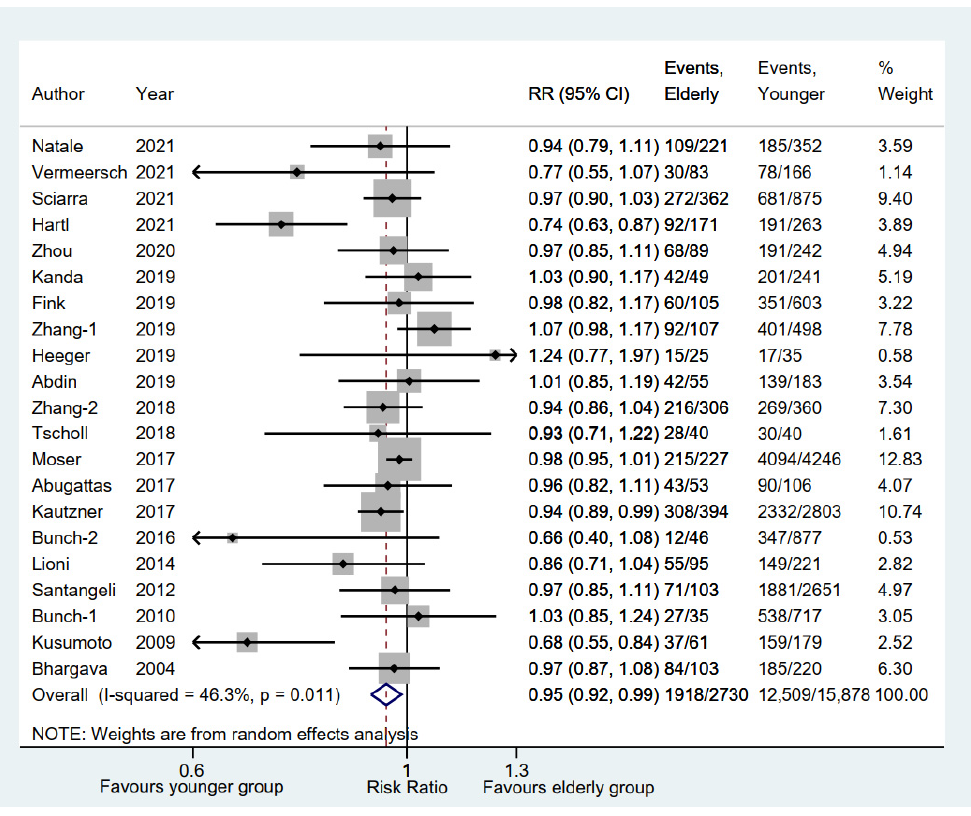
Figure 2. Forest plot of the freedom rate from AF between elderly and younger groups [6,10–17,19–27,29–31]. Comparison of the rates of freedom from AF between elderly and younger groups. AF: atrial